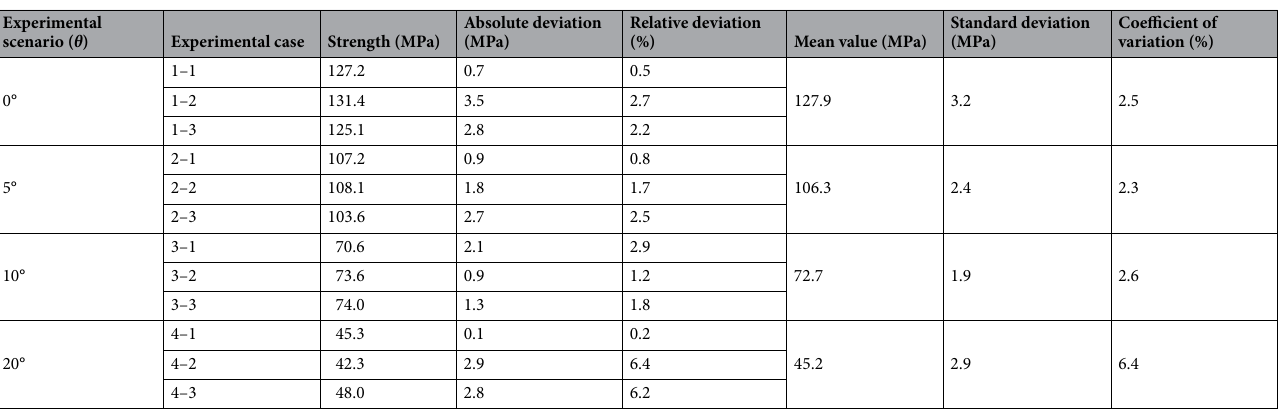
Table 1. Granite specimen peak compression strengths at different inclination